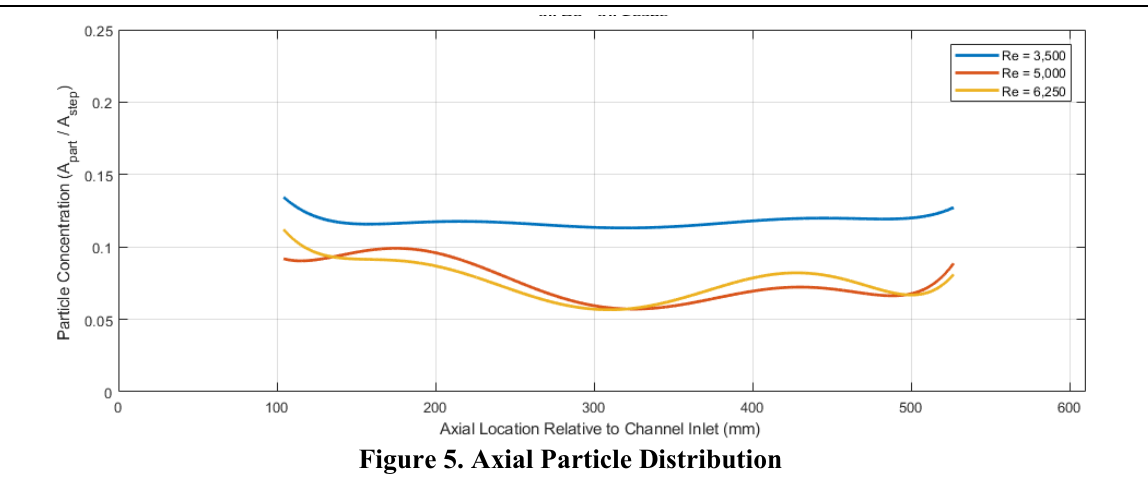
Figure 5. Axial Particle Distribution